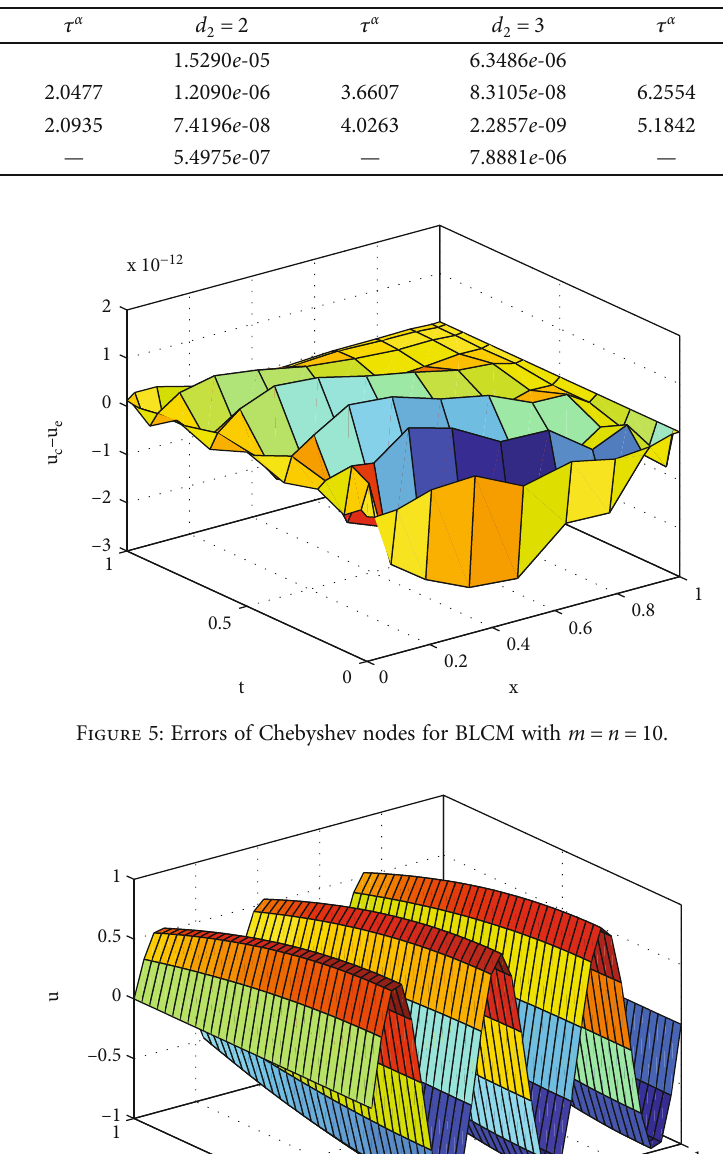
= 7 at t = 1 for Chebyshev nodes. 1